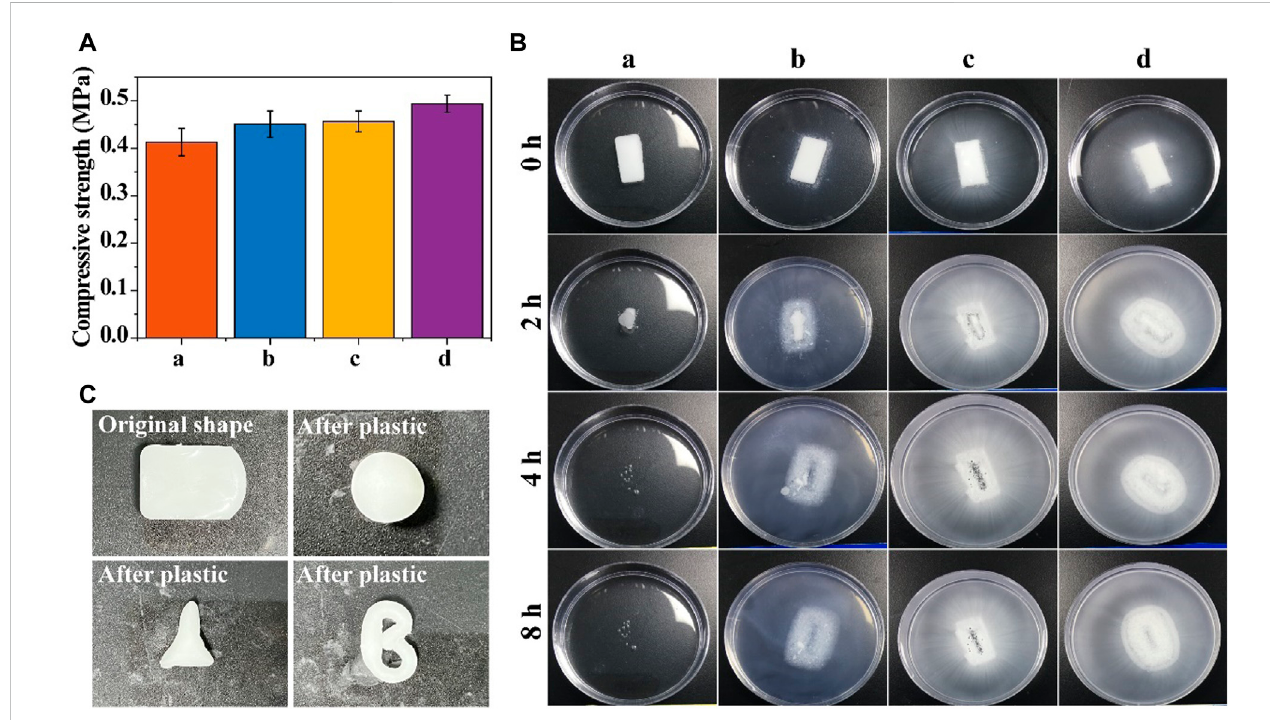
FIGURE 2 Physical properties of resorbable bone wax. (A) Compressive strength of bone waxes with different components. (B) Solubility of bone waxes in PBS buffer (0.01 M, pH 7.3 – 7.4). (C) Plasticity images of bone waxes a, b, c, and